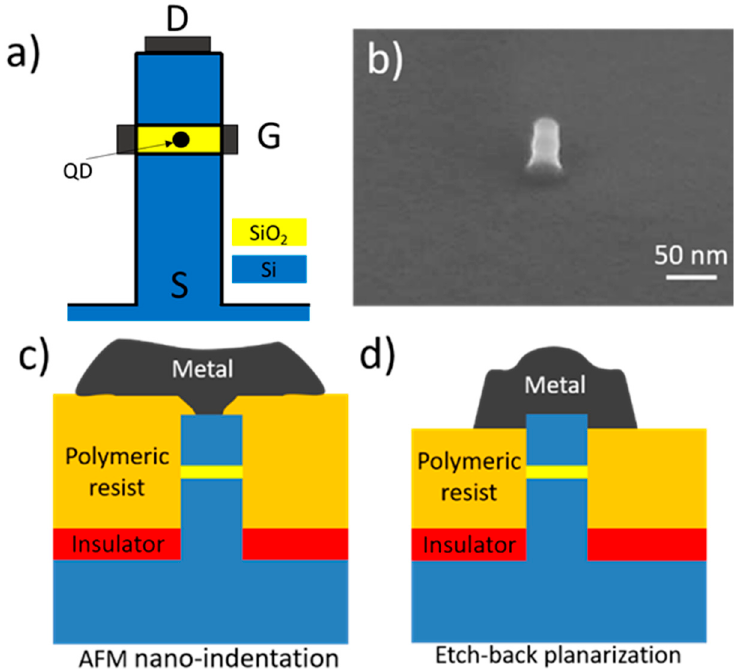
Figure 1. ( a ) Schematics of the concept based on vertical silicon nano-pillar: D: drain metal contact. G: gate metal contact. S: Source. QD: quantum dot embedded in a thin silicon layer. ( b ) SEM image of a vertical nano-pillar with the embedded silicon oxide layer (without metal contact). ( c ) Schematics showing a top metal contact performed by means of AFM nano-indentation. ( d ) Schematics of a top-metal contact performed by resist